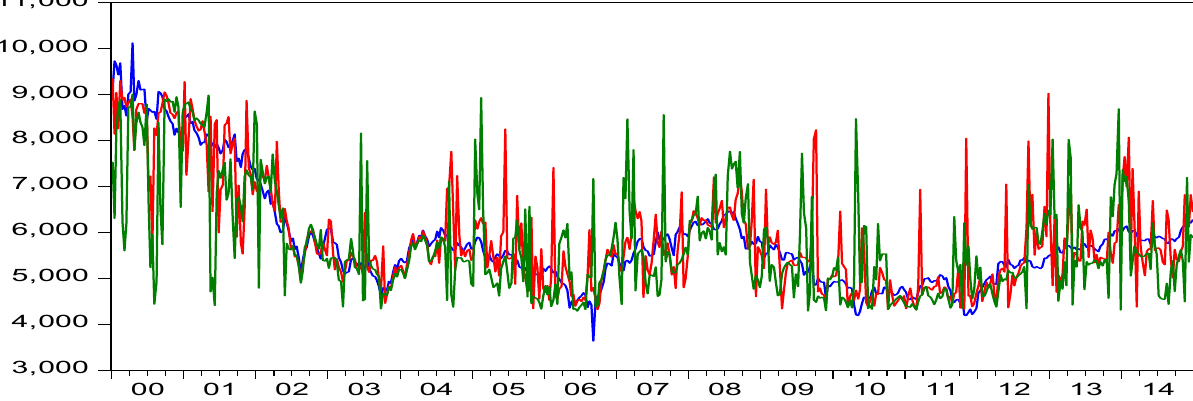
Figure 3. The time-varying beta herding for a rolling forecast of 5 (green lines) and 10 days (red lines) of estimation compared to the actual Taiwan market index (blue lines).